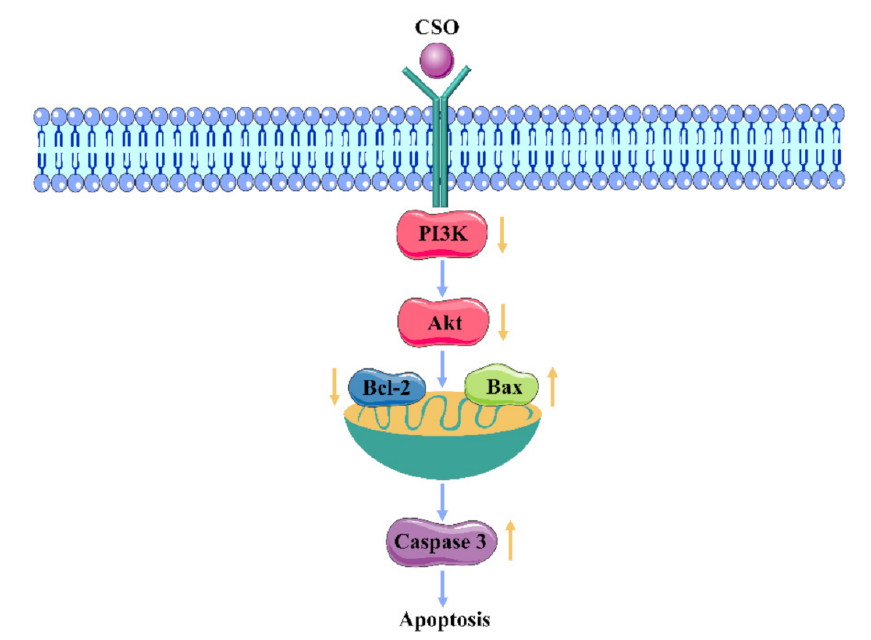
Figure 8. Model of the mechanism of CSO action on HT-29 cells by regulating the PI3K/AKT